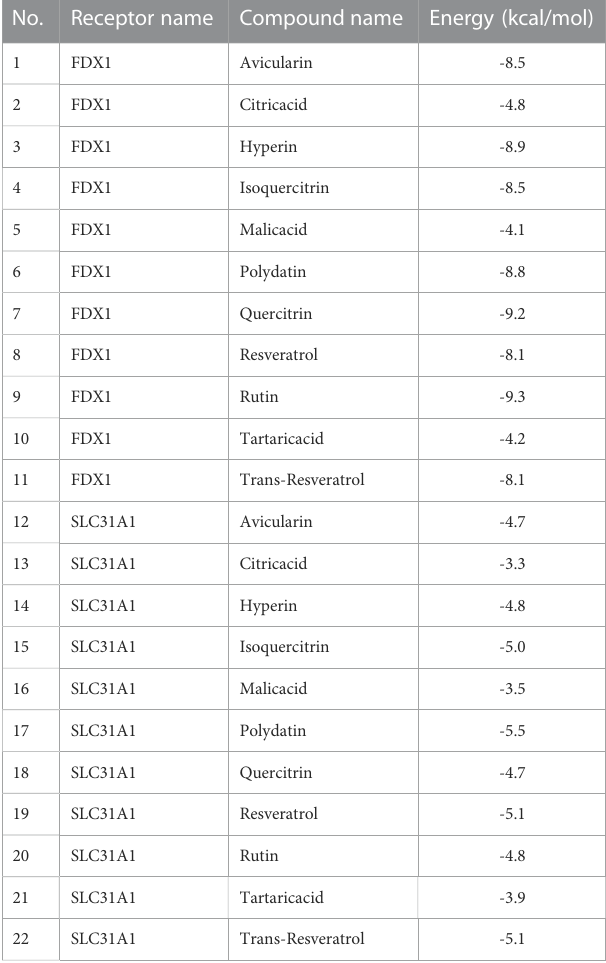
TABLE 2 molecular docking analysis.